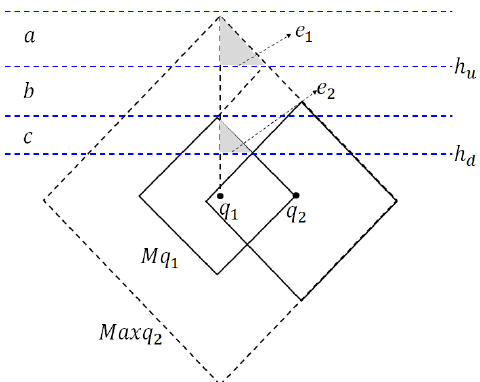
Figure 10 Minimum and maximum distances of